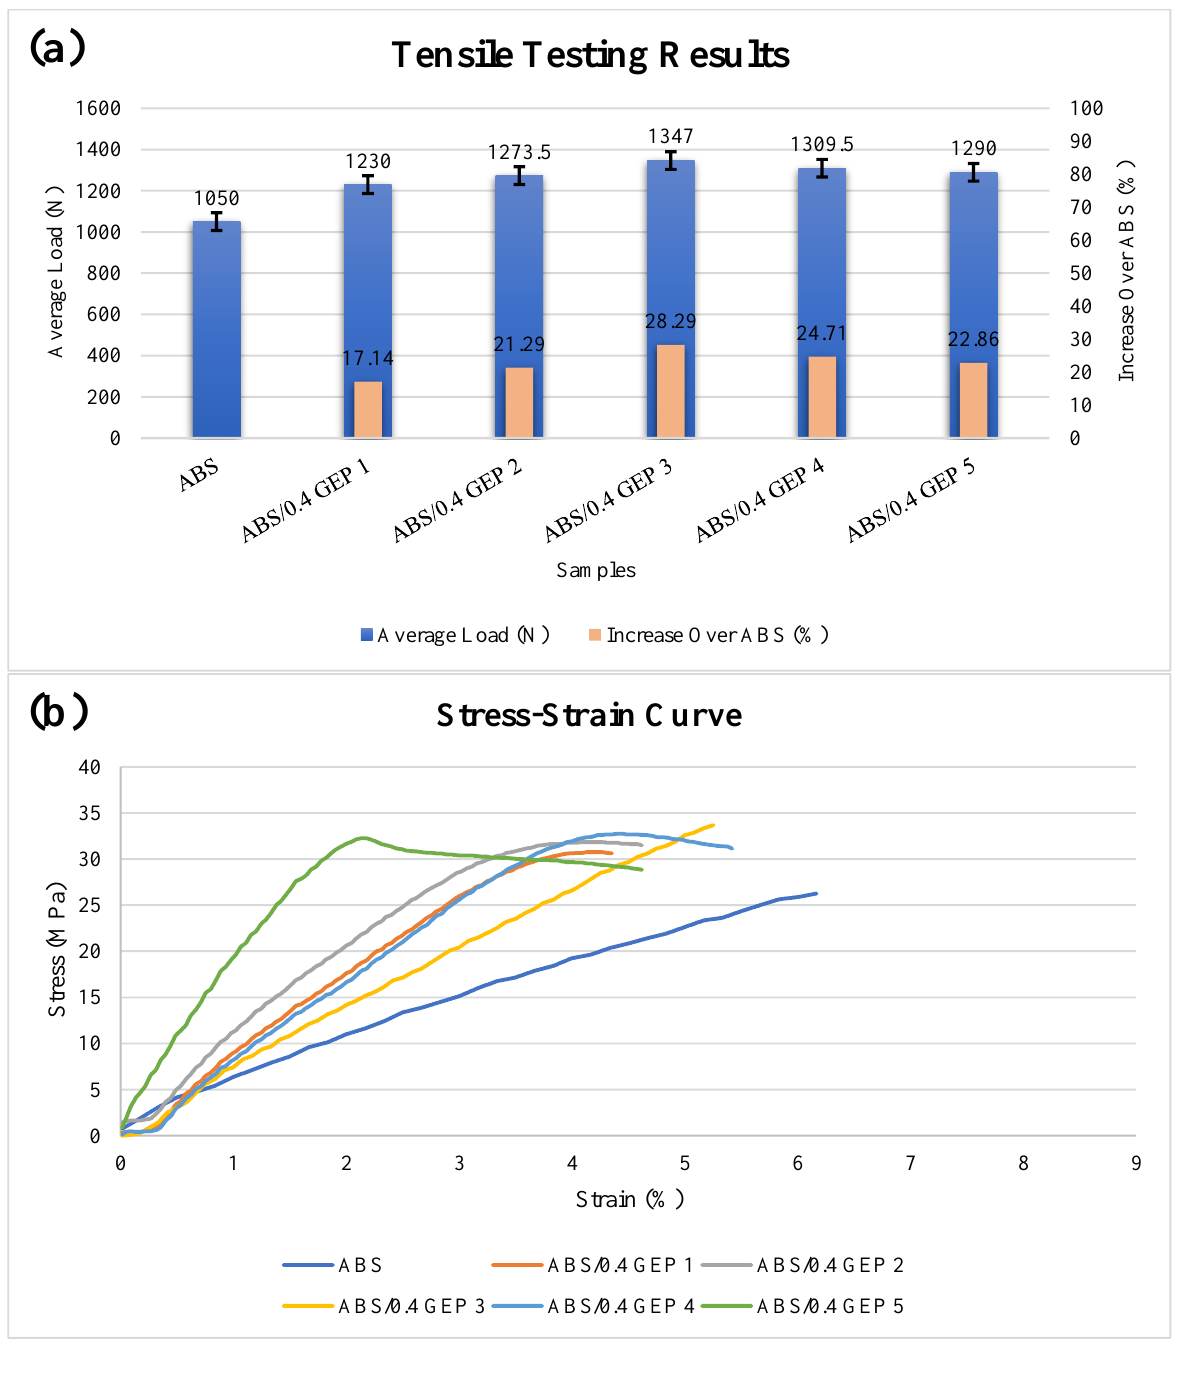
Figure 15. Comparative tensile test results for ABS/0.4 GEP composites: ( a ) results from tensile testing with standard deviation as error bars; ( b ) stress-strain curve.